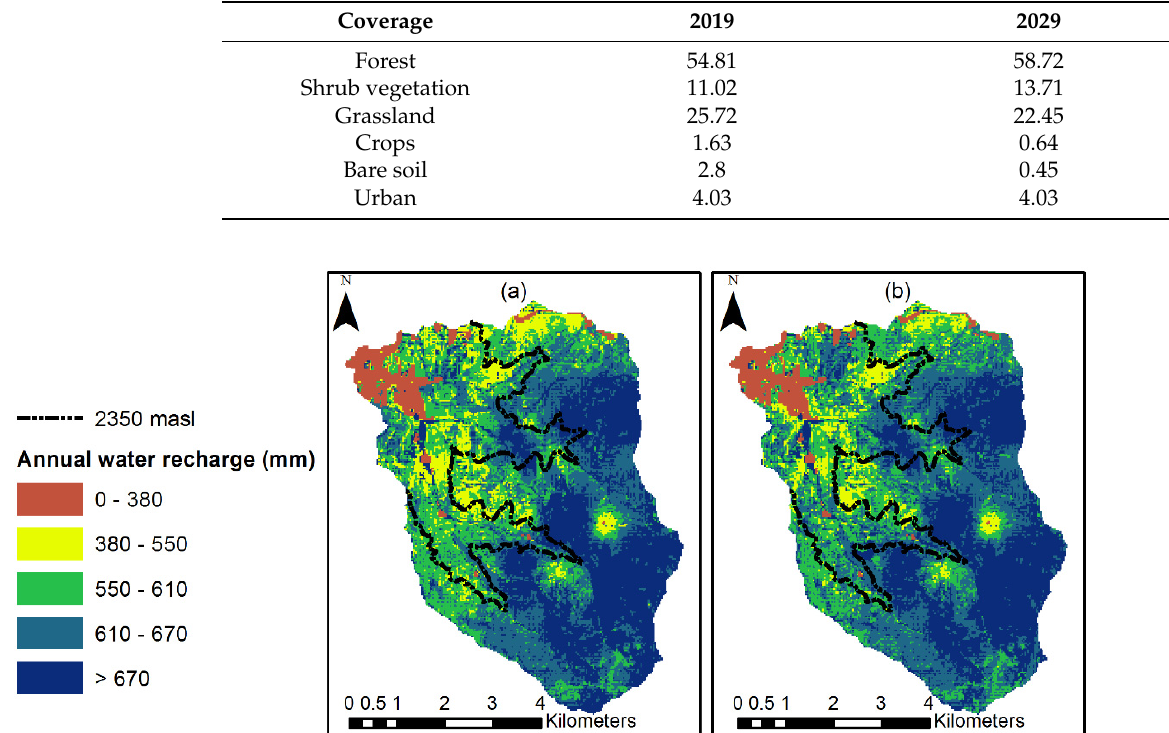
Figure 4. Multi-year average hydric recharge for ( a ) LULC scenario (1) and ( b ) LULC scenario (2).